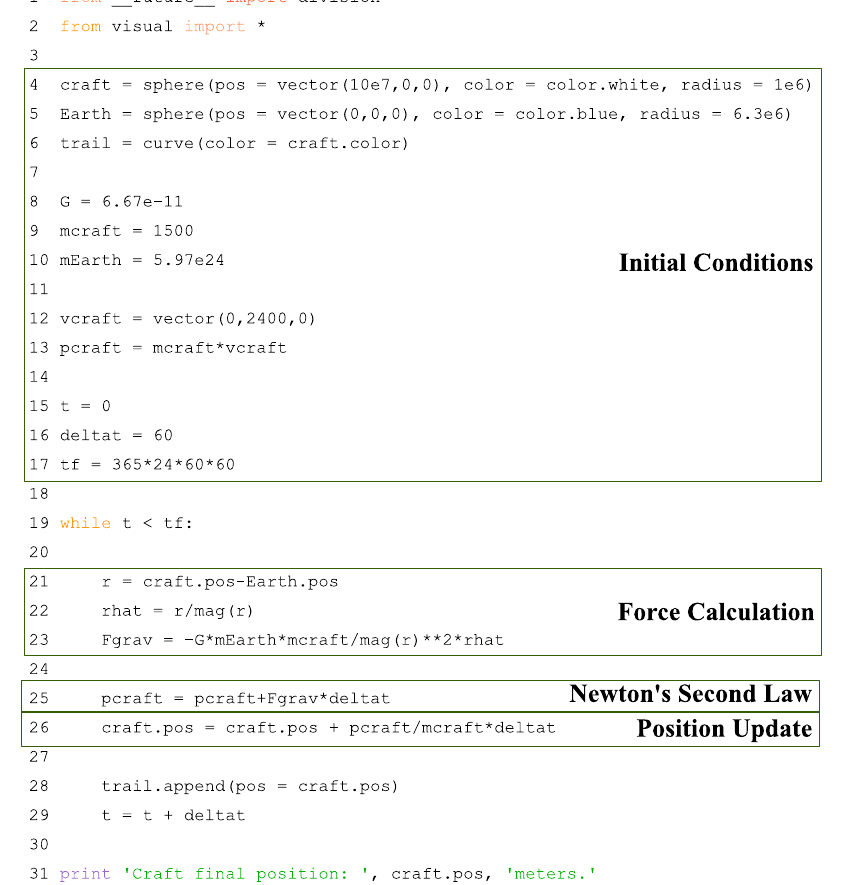
FIG. 1 (color online). Under the guidance of their TAs, students wrote the VPython program above in the laboratory. This program modeled the motion of a craft (size exaggerated for visualization) orbiting Earth over the course of one ‘‘virtual’’ year. To construct this model, students had to create the objects and assign their positions and sizes (lines 4–6), identify and assign the other given values and relevant initial conditions (lines 8–10, 12–13, and 15–17), calculate the net force acting on the object of interest appropriately (lines 21–23), and update the momentum and position of this object in each time step (lines